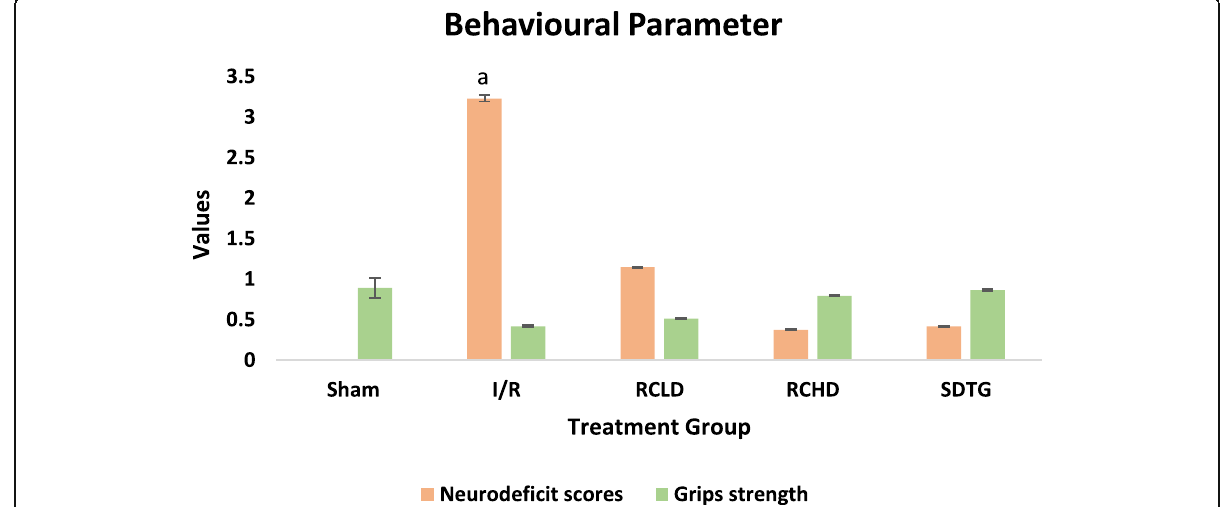
Fig. 2 Behavioral parameter estimation (neuro deficit score and grip strength) in different treatment groups. Where, values are indicated as mean ± SEM; ( n = 5) in each group. Data were subjected to one-way ANOVA followed by Dunnett ’ s test when RCLD, RCHD, and SDTG groups were compared to the I/R group, while the I/R group was compared to the Sham group. a p < 0.01, when compared to Sham Group, c p < 0.01 when compared to I/R group. The neuro deficit score was expressed in number while grip strength is expressed as kilogram (kg)